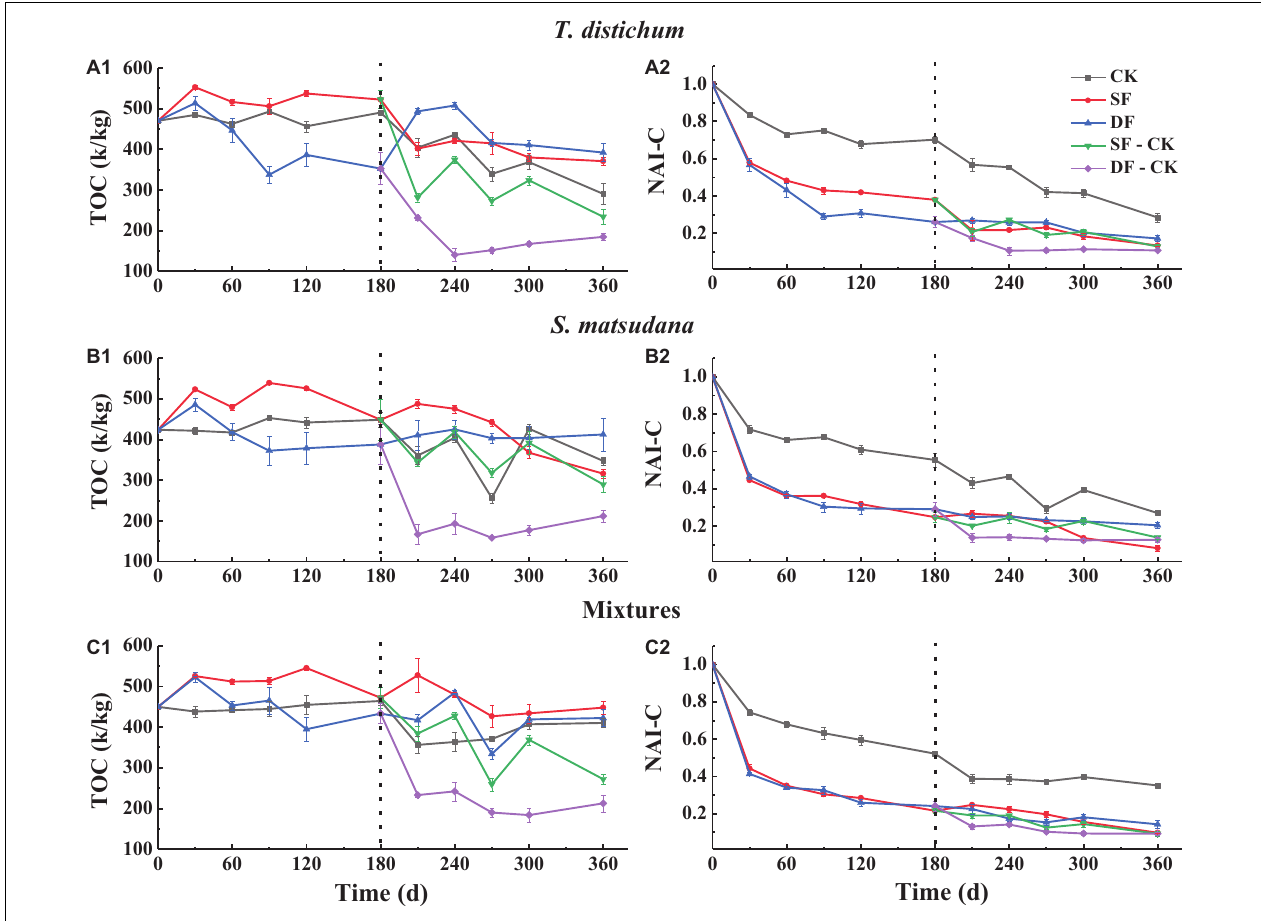
FIGURE 3 | The variation of total carbon concentration (A1–C1) and NAI-C index (A2–C2) during the process of foliage decomposition. CK, unflooded; SF, shallow flooding; DF, deep flooding; SF-CK, first half a year SF followed by half a year CK; DF-CK, first half a year DF followed by half a year CK.